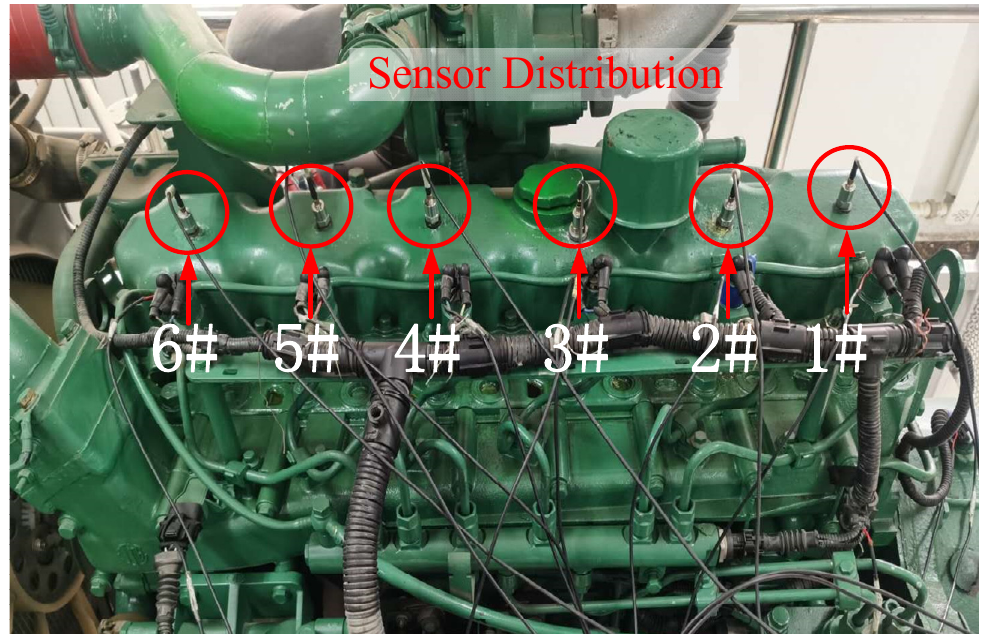
Figure 6. The deployment location of the vibration